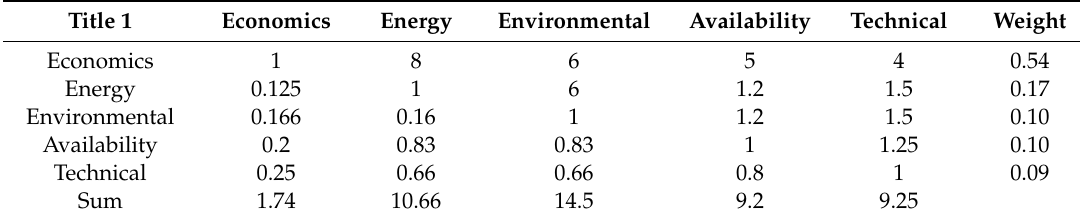
Table 2. Pairwise comparison of